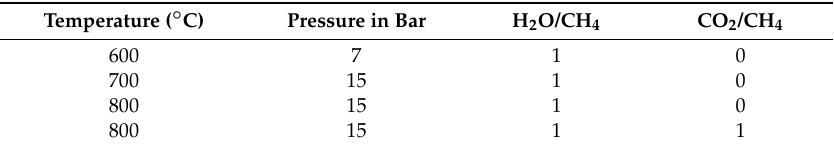
Table 4. Parameter combinations for which deviation in prediction of carbon formation is observed between Aspen and FactSage